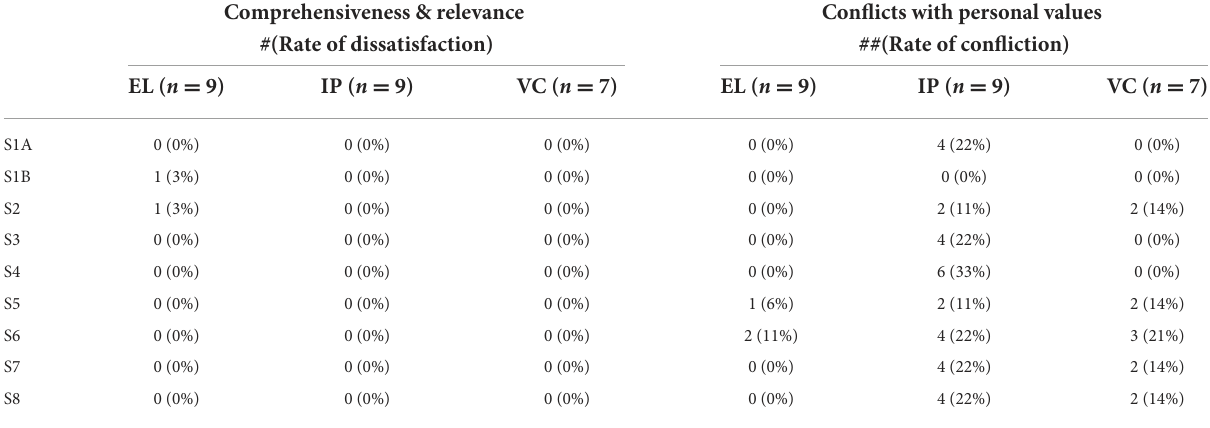
TABLE 2 Post-session Feedback Form-Caregiver (Comprehensiveness & relevance, agreement with personal